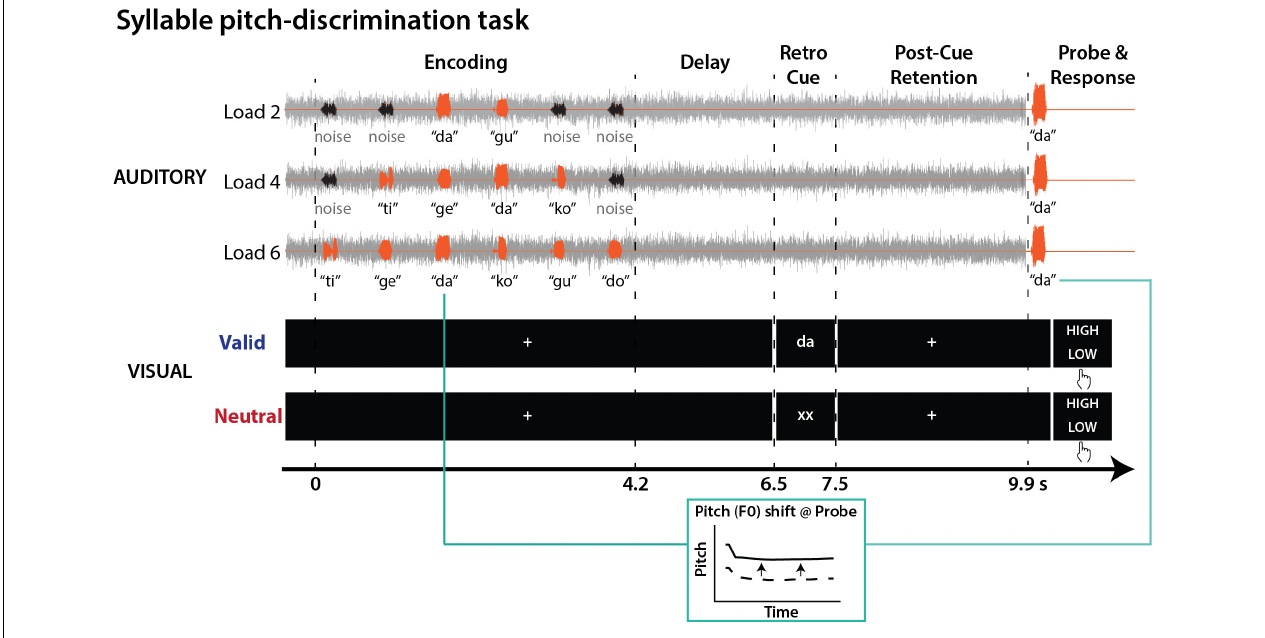
FIGURE 1 | Syllable-pitch discrimination task structure. On each trial, speech syllables (orange) and noise bursts (black) were presented against a speech-shaped noise masker (gray). Participants judged whether the pitch of the probe syllable was higher or lower in comparison to the same category syllable heard during encoding. During memory retention, either a valid (e.g., “da”) or neutral (“xx”) visual retro-cue was